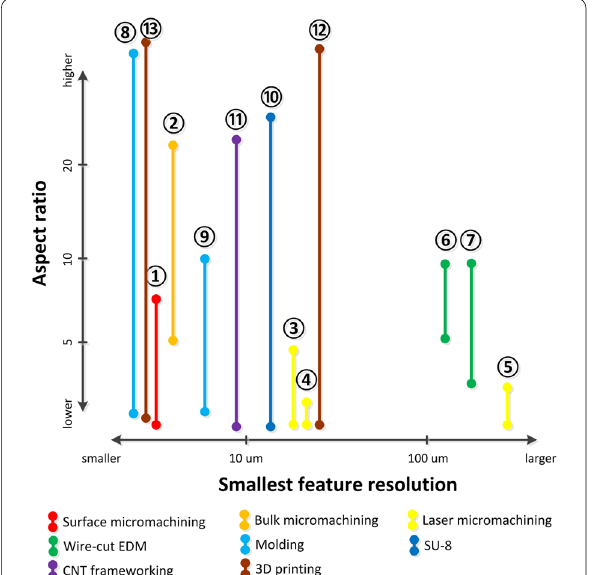
Figure 12 Graph of smallest feature resolution vs. aspect ratio range depending on the process material